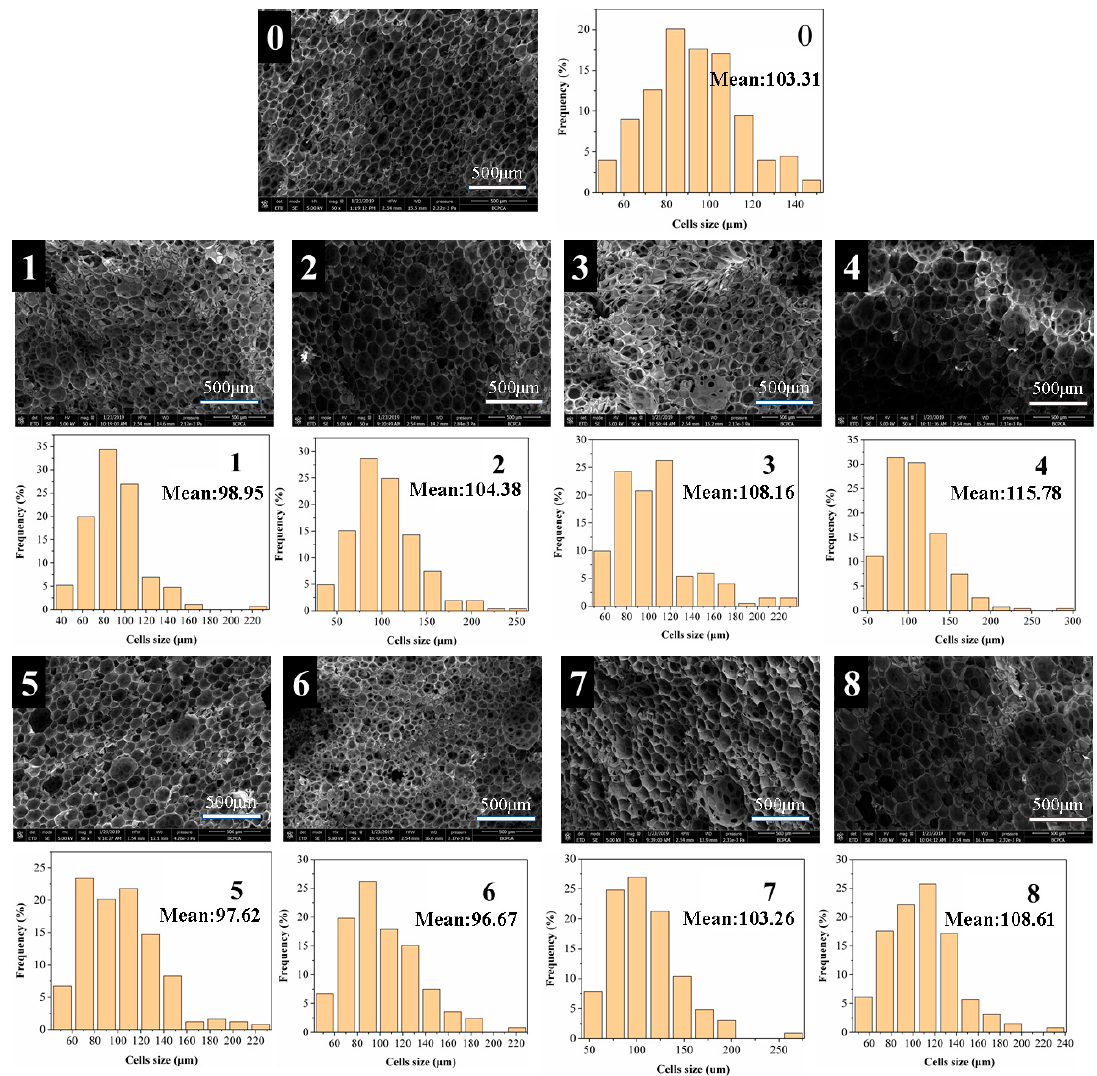
Figure 3. SEM images and cell size distributions of the PF ( 0 ), FPFs ( 1 – 4 ), and FTPFs ( 5 – 8 ).